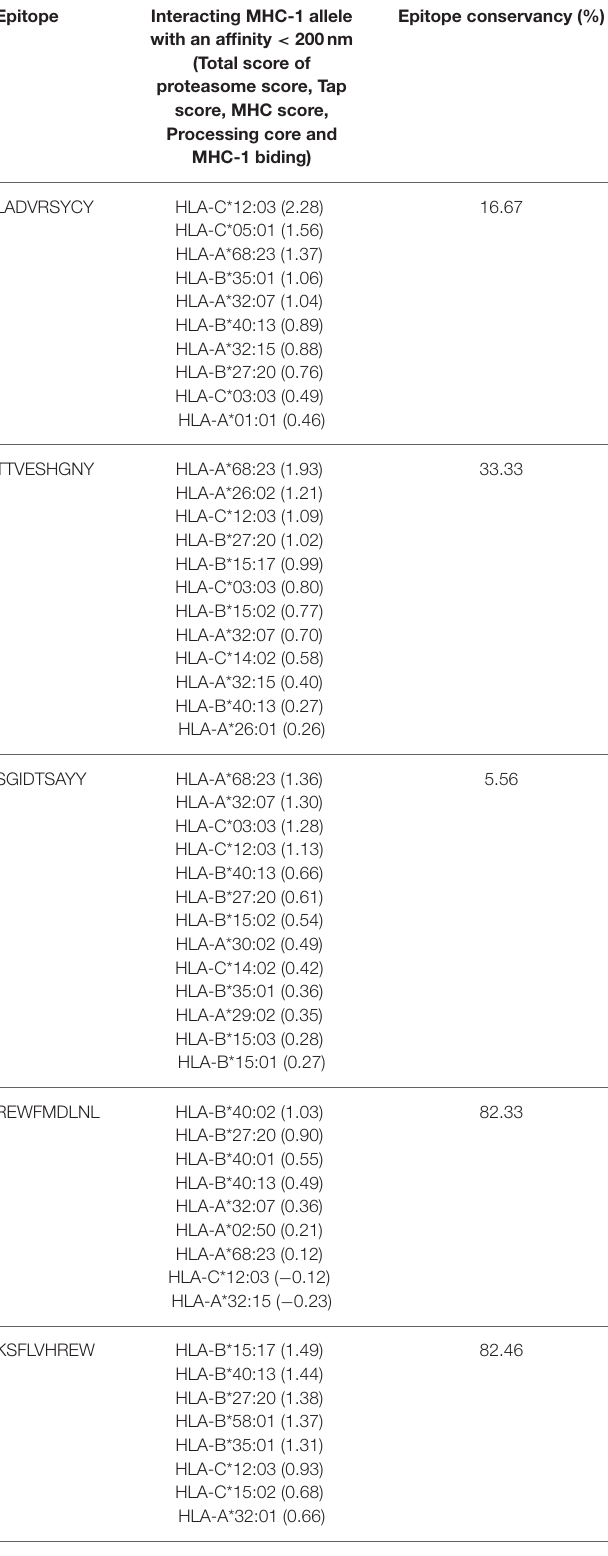
Epitope Interacting MHC-1 allele with an affinity < 200nm (Total score of proteasome score, Tap score, MHC score, Processing core and